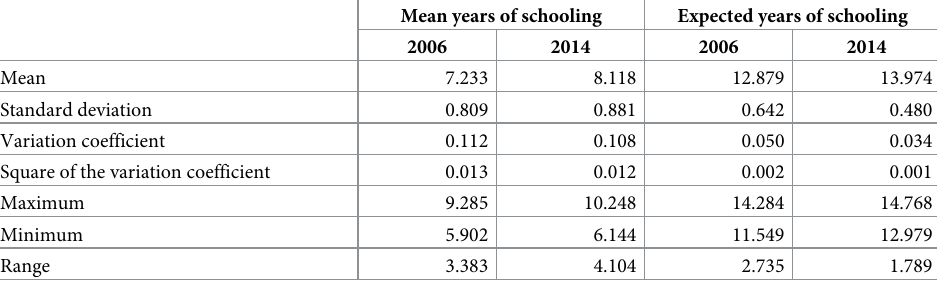
Table 4. Descriptive summaries of education indicators.